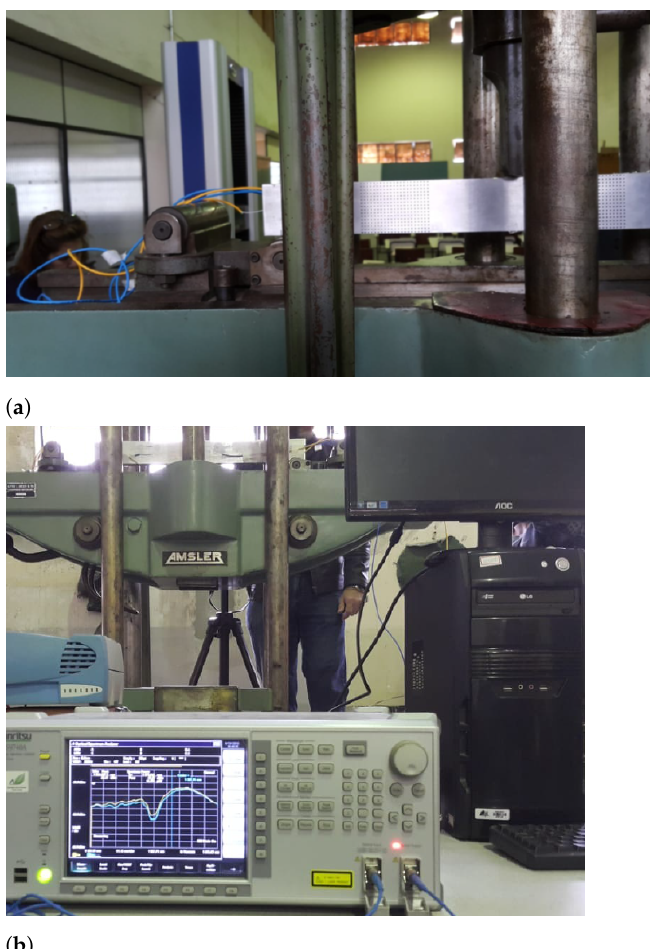
Figure 5. Experiment configuration ( a ) Camera positioned in front of the experiment ( b ) Aluminum bar under 610 kg